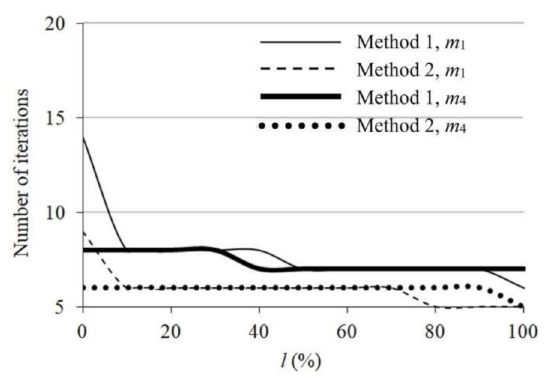
Figure 7. The number of iterations in the state-estimation process for load level V 0.5 .